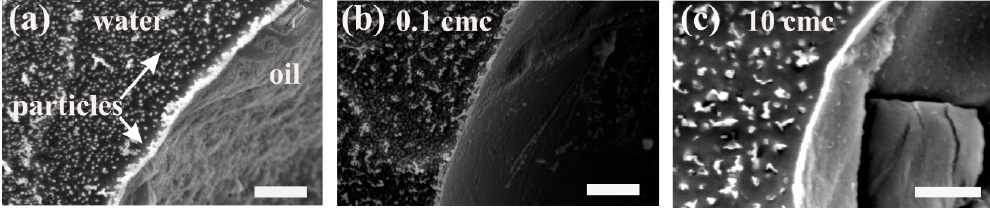
Figure 2. Electron microscopy images of the oil-water interface in a Pickering emulsion mixed with surfactant at concentrations of ( a ) 0 M; ( b ) 10% of the critical micelle concentration; and ( c ) ten times the critical micelle concentration [34]. The layer of densely packed particles at the drop surfaces is disrupted by surfactant adsorption at concentrations below the critical micelle concentration. The particles are completely displaced from the interface at surfactant concentrations above the critical micelle concentration. The scale bars correspond to 2 µ m in the left and middle images and 1 µ m in image on the right. Adapted from [34] with permission from